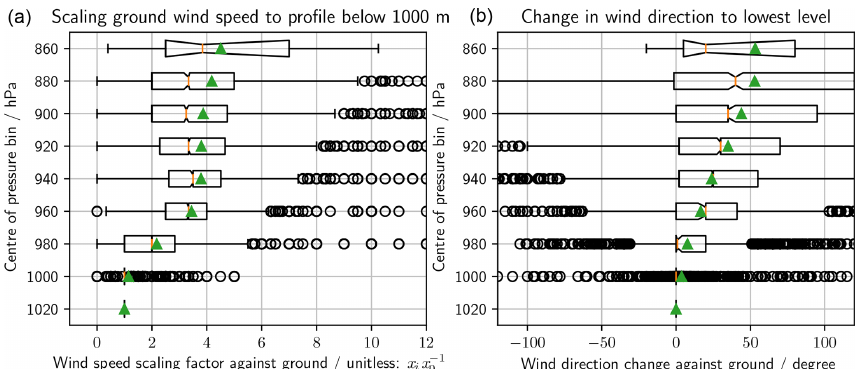
Figure 4. Wind speed profile statistics (a) and wind direction statistics (b) up to 1000m at Tateno, Japan, using data from 2009 to 2016, from the Ijima (2016) dataset. Values are calculated by dividing the wind speed at a given pressure by the wind speed at the lowest level. The box plots show the median (red line) and the mean (green triangle). A total of 50% of values are within the box, the whiskers include 95% of the values, and the rest are shown as outliers (black circles). The notch in the box shows the uncertainty of the median calculated via resampling.